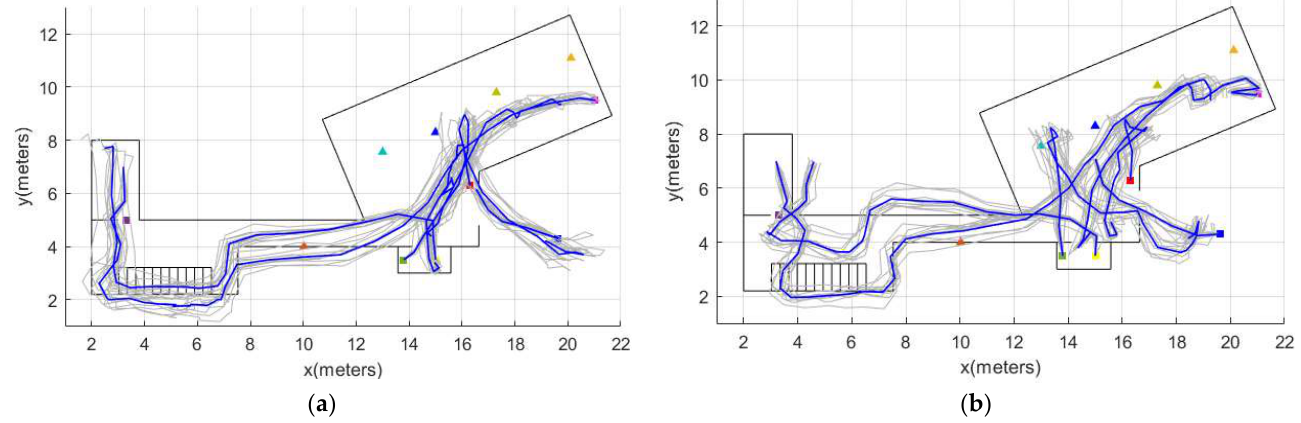
Figure 7. Example of location tracking. ( a ) Participant 9 of the older adults group. ( b ) Participant 2 of the older adults group. Table 8. Student’s t -test result. Comparison of errors between older adults and control group.